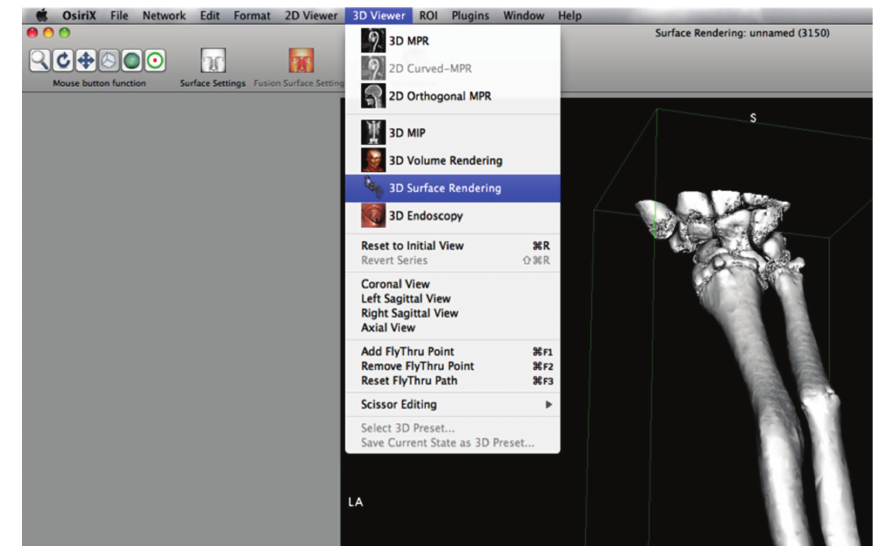
Figure 5: Surface rendering.